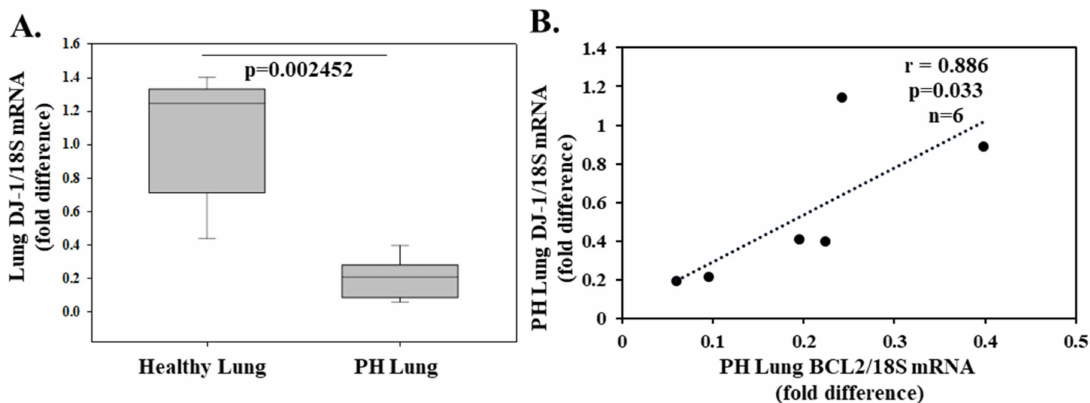
Figure 3. Lung DJ-1 expression is decreased in patients with pulmonary hypertension (PH). In a prospective study, 12 patients of whom 6 (4 male and 2 female; mean ± SEM age 59.8 ± 4.4 years) were cancer patients negative for lung malignancy with a pulmonary artery systolic pressure <25 mmHg and 6 (4 male and 2 female; mean age 64.5 ± 3.1 years) with thromboembolic pulmonary hypertension negative for malignancy with a mean ± SEM pulmonary artery systolic pressure of 70 ± 4 mmHg. The lung biopsies were taken from the left lower lobe by video-assisted thoracic surgery. The pulmonary artery systolic pressure was assessed using echocardiography measuring maximal tricuspid regurgitation velocity and applying the modified Bernoulli equation to convert this value into pressure. The study was approved by the ethics committee of the University of Athens General Hospital Attikon, and informed consent was obtained from all patients. DJ-1, BCL2, and 18S (housekeeping) gene expression in the lung was determined by real-time quantitative (RT-PCR). DJ-1/18S mRNA in PH was calculated as a fold change over healthy and presented as box plots showing the median and interquartile range. p value shown ( A ). Positive correlation between anti-apoptotic BCL2 and DJ-1 in PH patients ( B ).